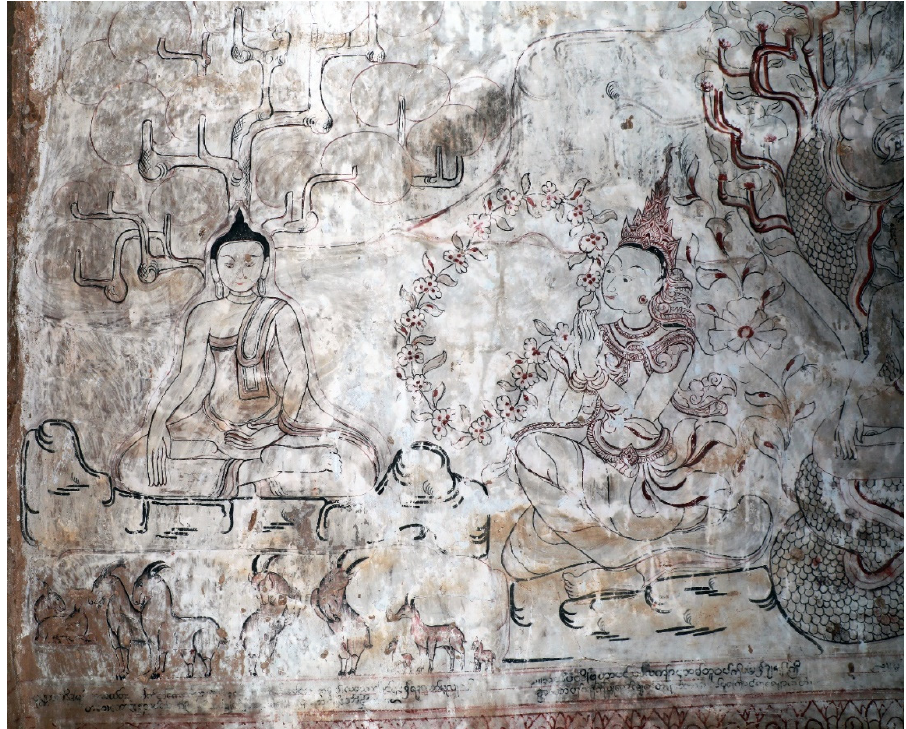
Figure 6. The Buddha under the Ajap ā la Banyan tree of the goatherder, Brahm ā to the left of the Blessed One, the Fifth Week. Sulamani temple, Bagan.